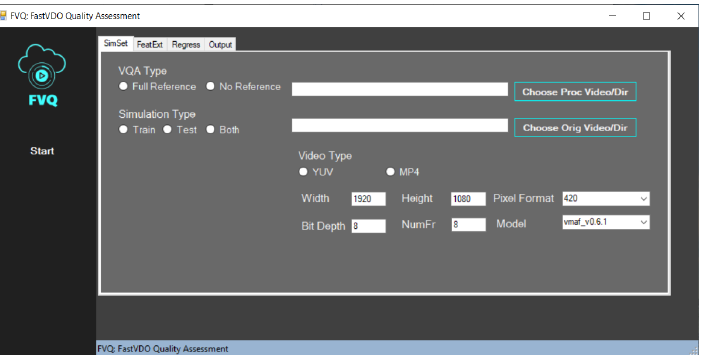
Figure 7. ( left ) Correlation coefficients PCC and SRCC of VMAF features to user ratings on the NFLX-II data; ( center ) Correlation coefficients of VIDEVAL features on the YouTube UGC data; and ( right ) the mean of PCC and SRCC for the top 25 features from the RAPIQUE feature set (from 3884 features). All VMAF features appeared useful, and were used (Figure 2); in Figure 4, we used all 60 VIDEVAL features.